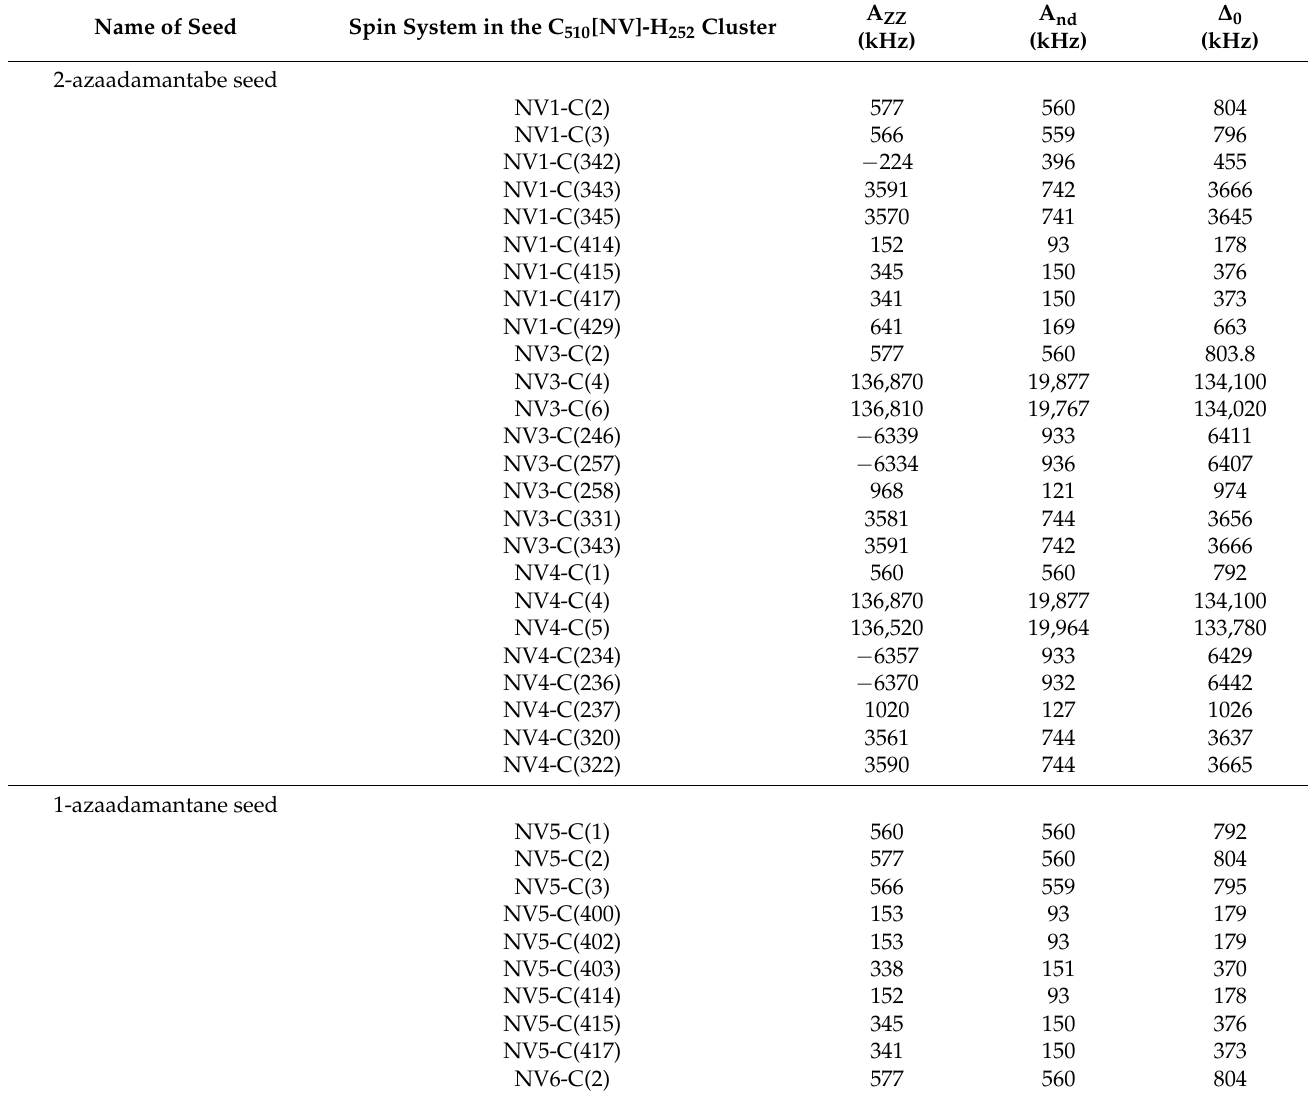
Table 1. Predicted values of the hfi parameters A ZZ and A nd = ∆ ± 1 sublevels for various NV- 13 C systems in diamond grown from isotopic 2-azaadamantane and from 0 of the m S = 1-azaadamantane at four different positions of the vacancy in the formed NV